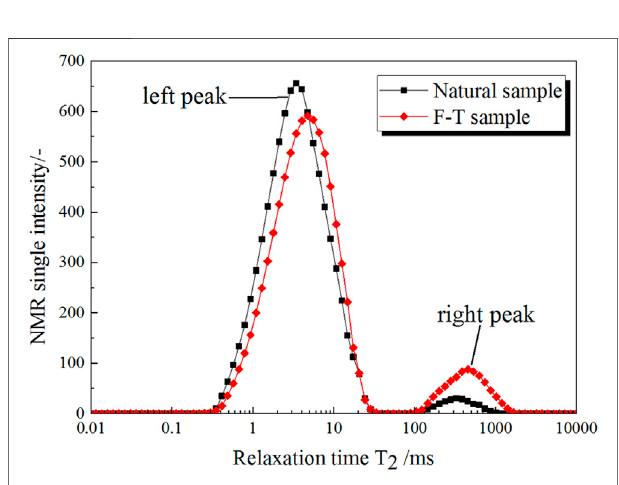
FIGURE 6 | T 2 distribution curves from NMR